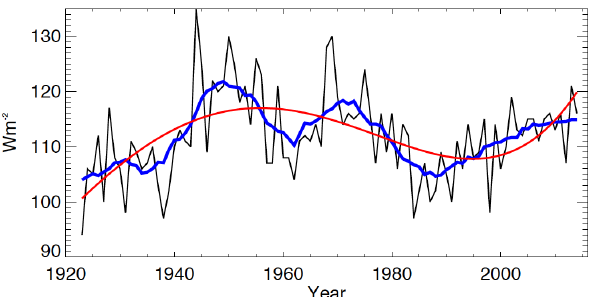
Figure 2. The longest continuous record available in GEBA: sur- face downward shortwave radiation (Wm − 2 ) measured in Stock- holm since 1922. The blue line shows the 5-year moving average; the red line shows the fourth-order polynomial fit. Substantial multi- decadal variations become evident, with an increase up to the 1950s (early brightening), an overall decline from the 1950s to the 1980s (dimming), and a recovery thereafter